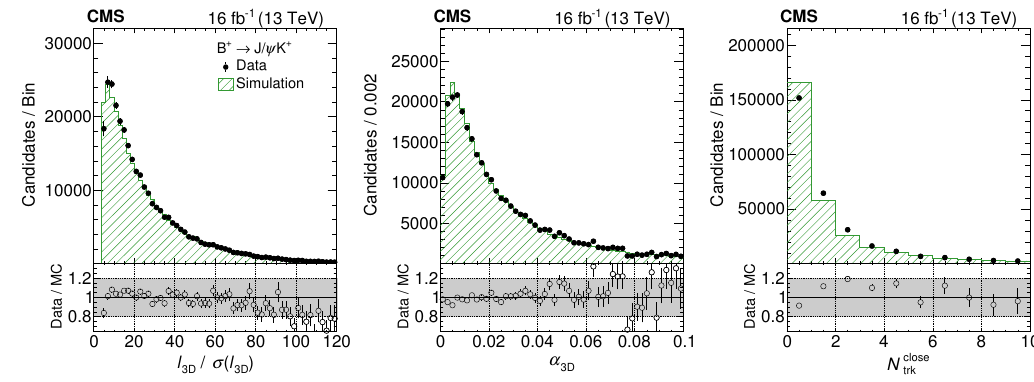
Figure 2 . Comparison of measured and simulated B + ! J = K + distributions for the most dis- criminating analysis BDT variables in the central channel for 2016B: the (cid:13)ight length signi(cid:12)cance, the pointing angle, and the number of tracks close to the secondary vertex. The events are required to pass the preselection for the analysis BDT training. See text for details. The background- subtracted data are shown by solid circles and the MC simulation by the hatched histogram. The MC histograms are normalized to the number of events in the data. The lower panels display the ratio of the data to the MC simulation. The band in the ratio plot illustrates a (cid:6) 20% variation. the uncertainty combines the statistical and systematic components (see table 3 below